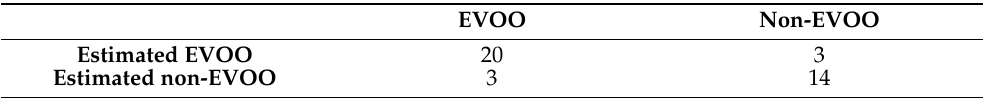
Table 5. Results of the KNN test in the case of two quality grade classes (EVOO and non-EVOO) and both the HAS and DW reagents.